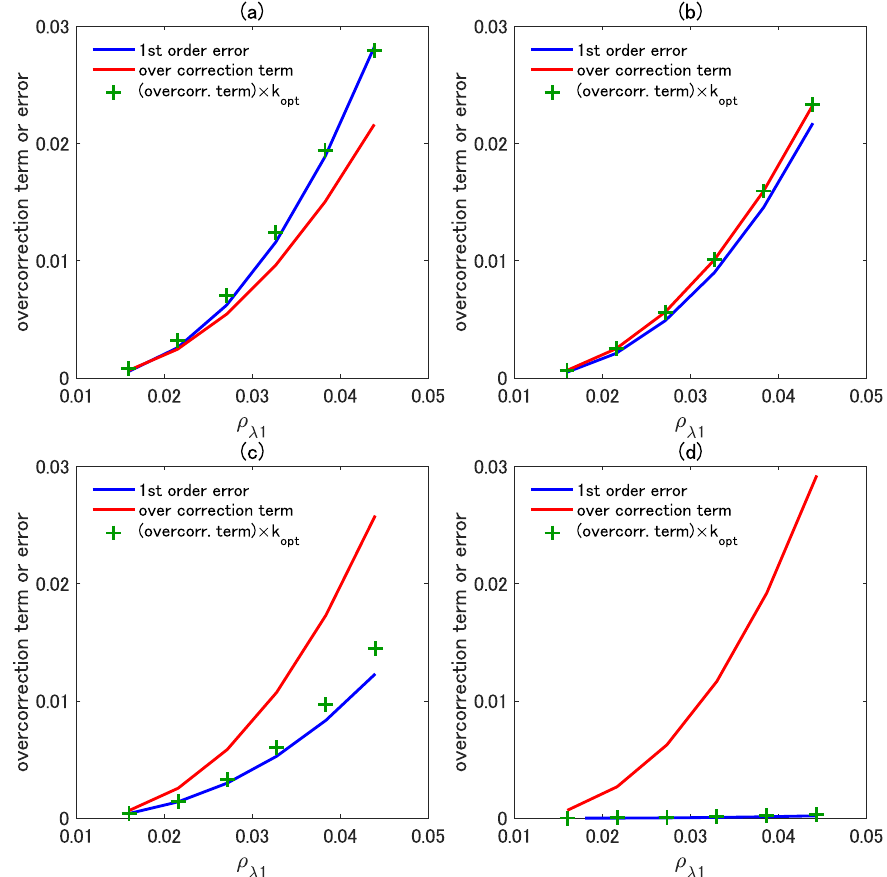
Figure 10. Plot of the error in the first-order vegetation isoline equation (blue line) and the over- correction terms of the asymmetric-order vegetation isoline equation (red line) and the adjusted overcorrection term with k opt (green crosses). The wavelength pair of λ 1 and λ 2 is the same as in Figure 9. The wavelength λ 2 was fixed at 860 nm, whereas λ 1 was selected from ( a ) 690 nm, ( b ) 710 nm, ( c ) 730 nm, and ( d ) 850 nm ( λ 2 minus